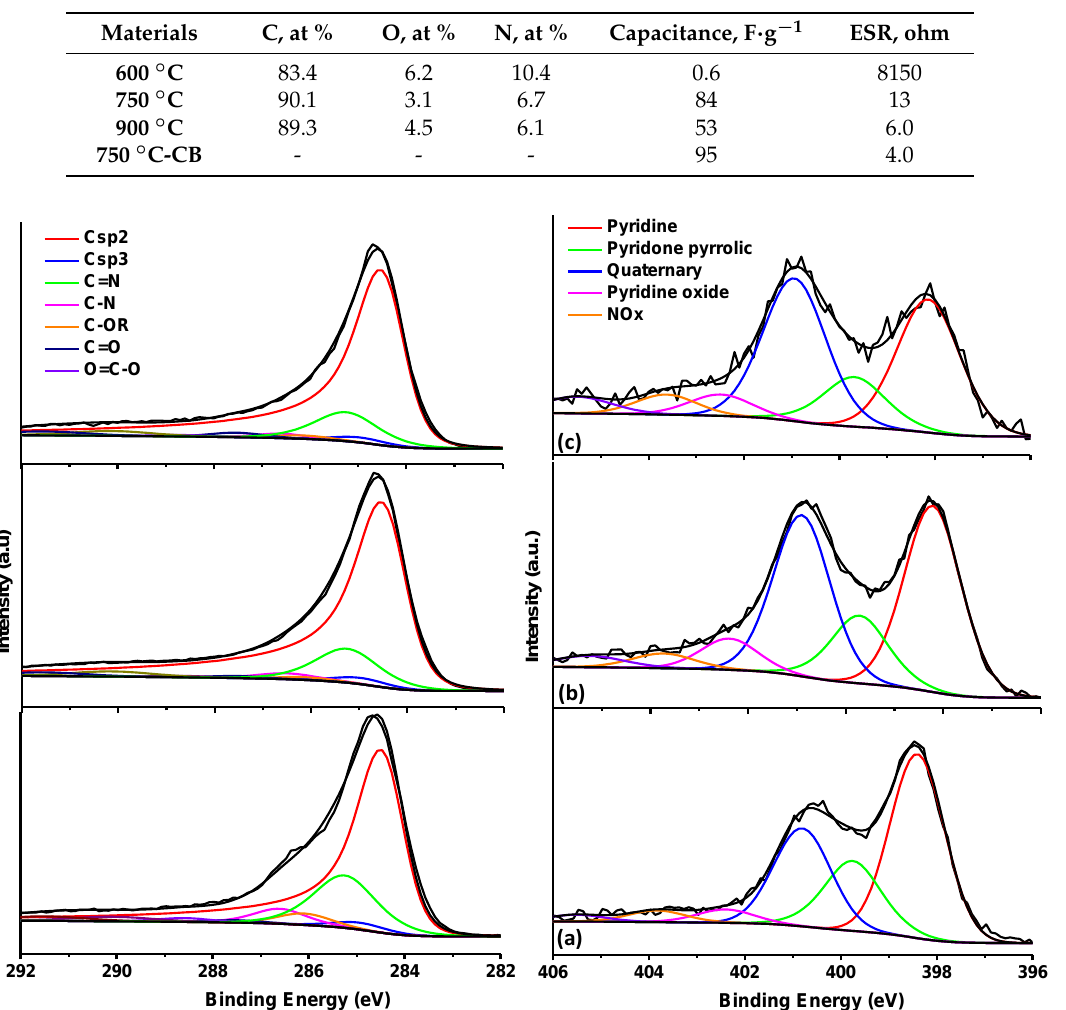
Figure 6. XPS deconvoluted spectra of the stirring procedure and different annealing temperatures